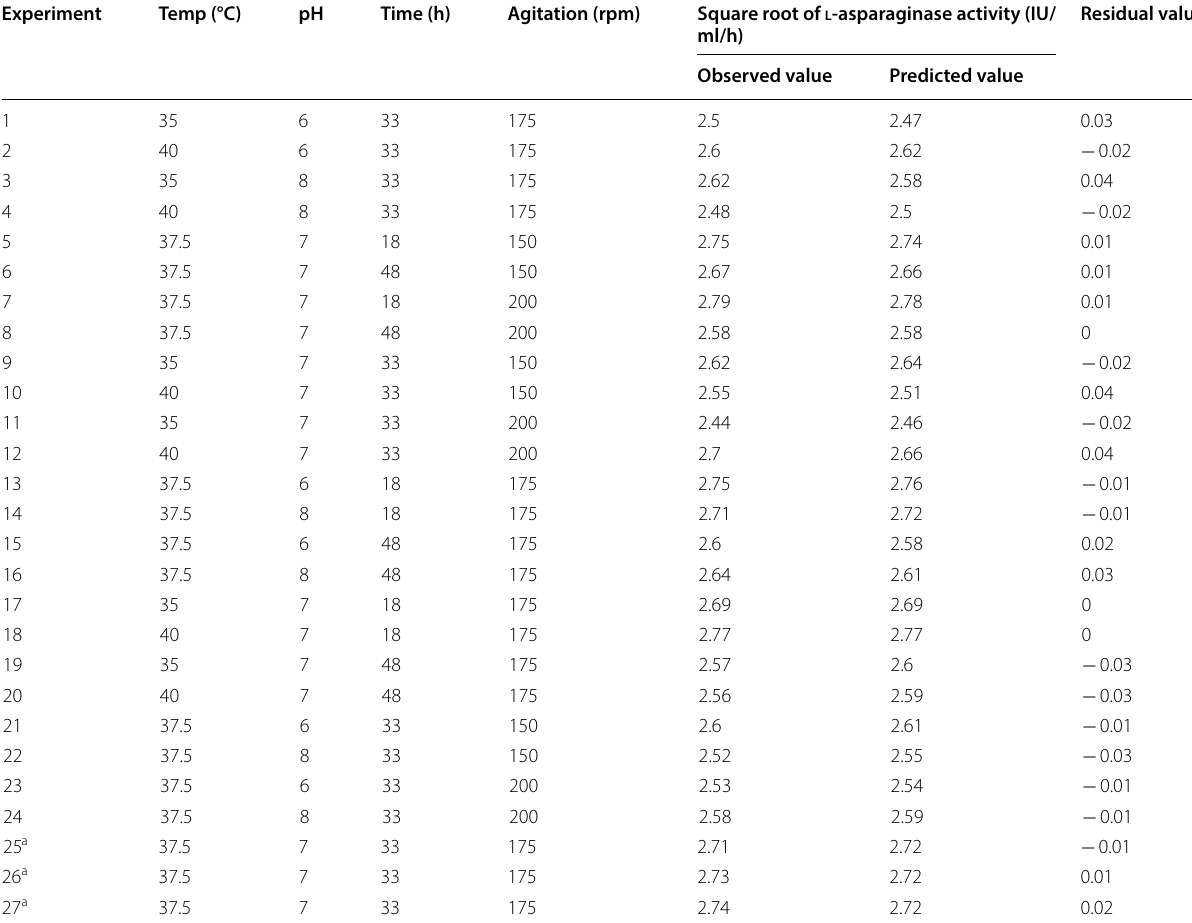
Table 2 Optimization of process parameters for l -asparaginase production by Stenotrophomonas maltophilia EMCC2297 variant using Box–Behnken design